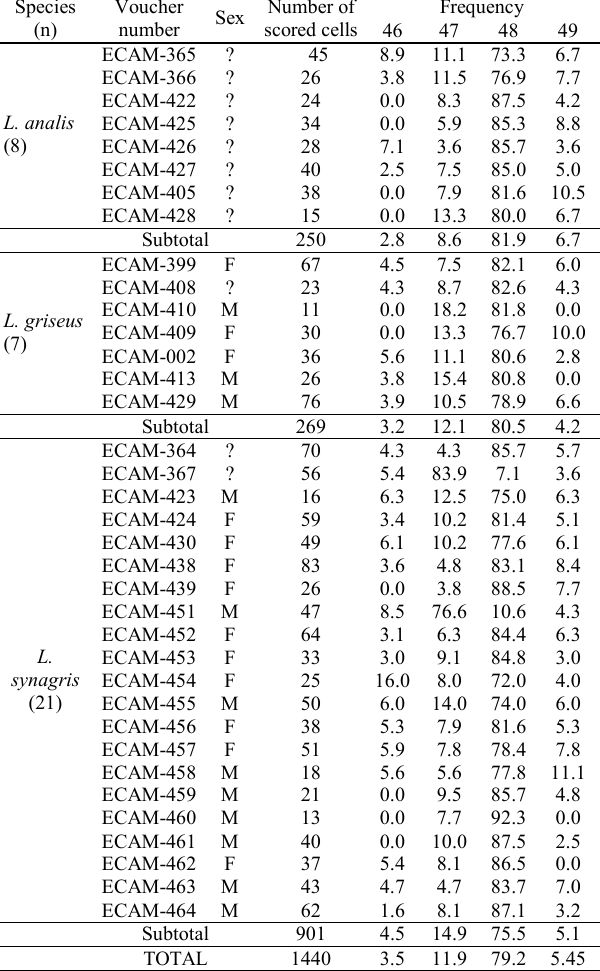
Table 1. Number of scored cell and percentages of different diploid counts in specimens of the three species of Lutjanus examined. Undetermined sex (?), male (M), and female